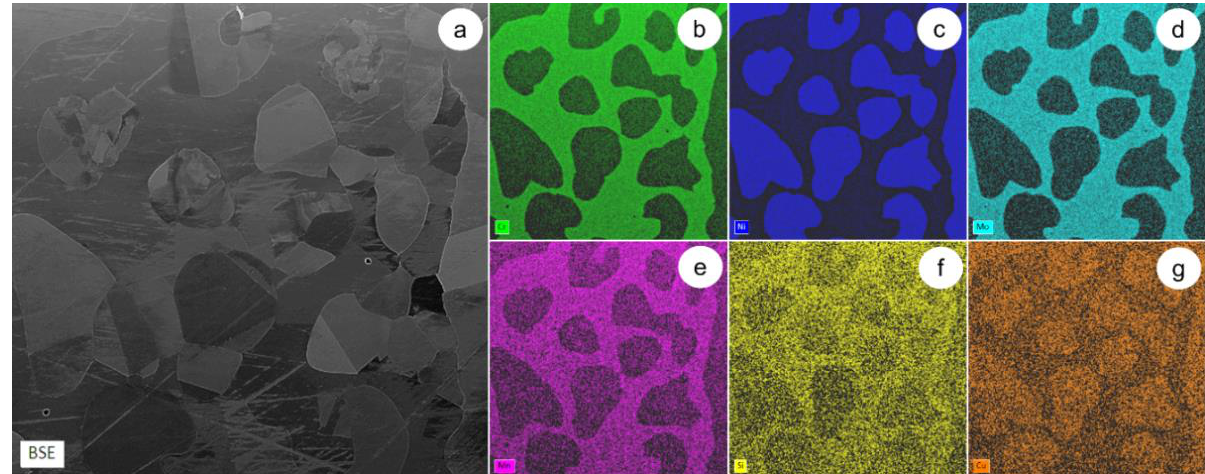
Figure 2. SEM-EDS colorized maps showing the main alloying elements distribution in the AR UNS S32750 Super-Duplex Stainless Steel: SEM-BSE image of the microstructure ( a ); distribution map of Cr ( b ); Ni ( c ); Mo ( d ); Mn ( e ); Si ( f ); Cu ( g ). Table 1. The average chemical composition of the AR UNS S32750 Super-Duplex Stainless Steel.